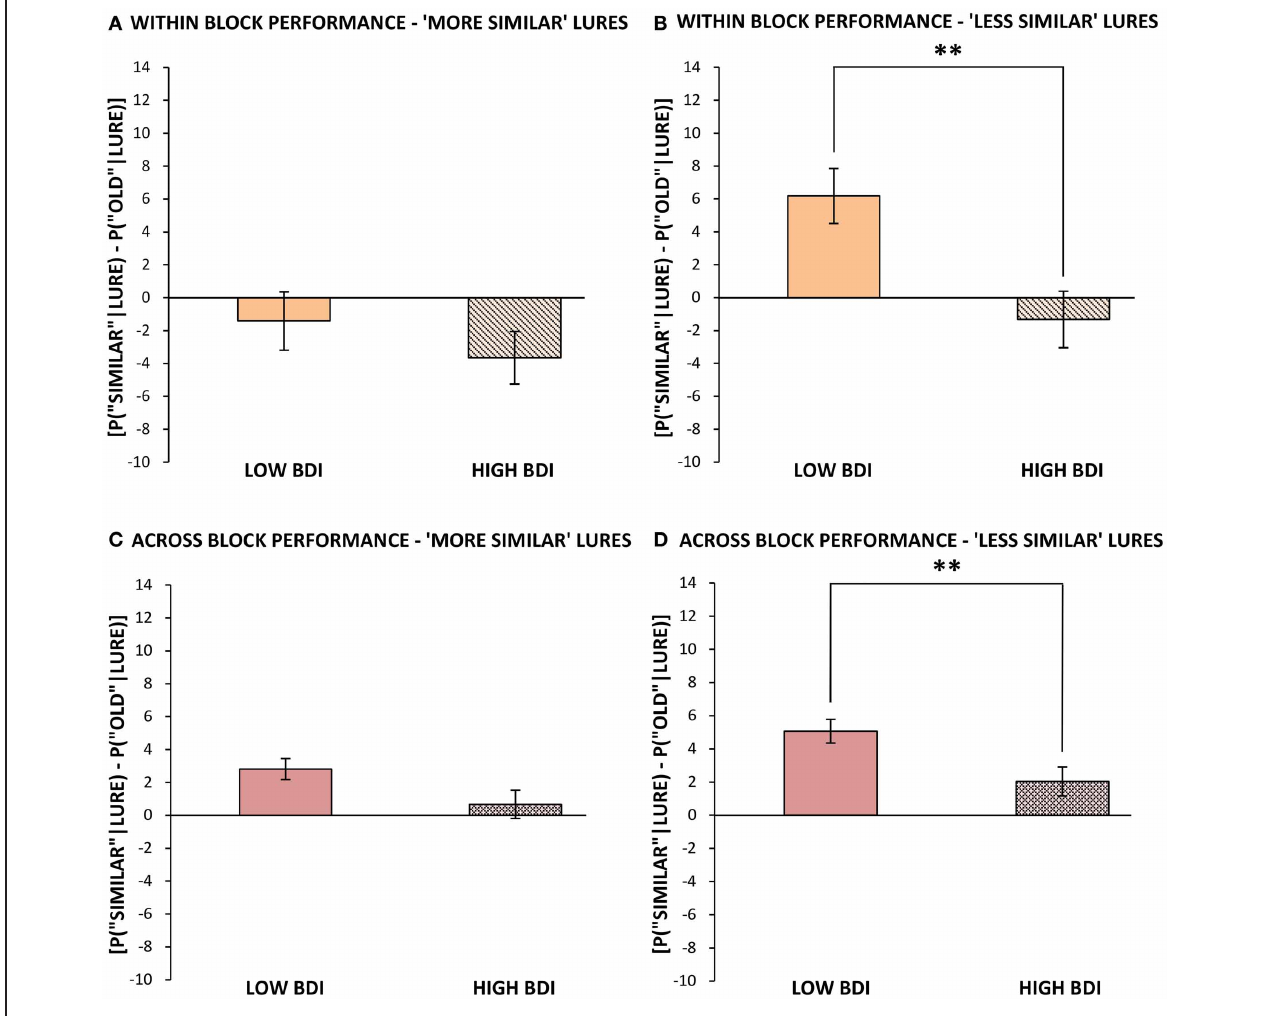
(A) for “more similar” lures, when target was within the same block, (B) for “less similar” lures, when target was within the same block, (C) for “moresimilar” lures,whentargetappearedinadifferentblock,and(D)for “less similar” lures, when target appeared in a different block. ∗∗ p ≤ 0 .